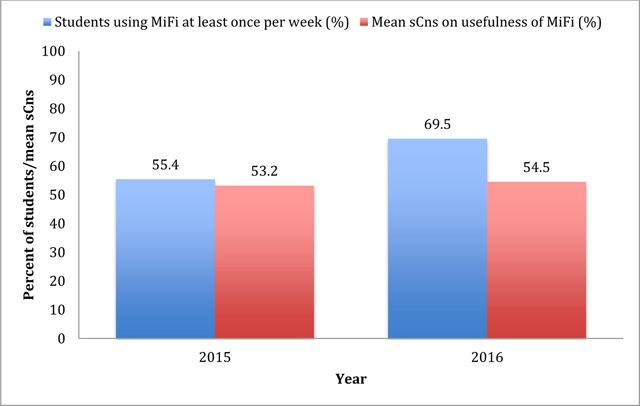
Frequency of use and mean consensus on usefulness of MiFi.sCns = Strength of consensus measure.